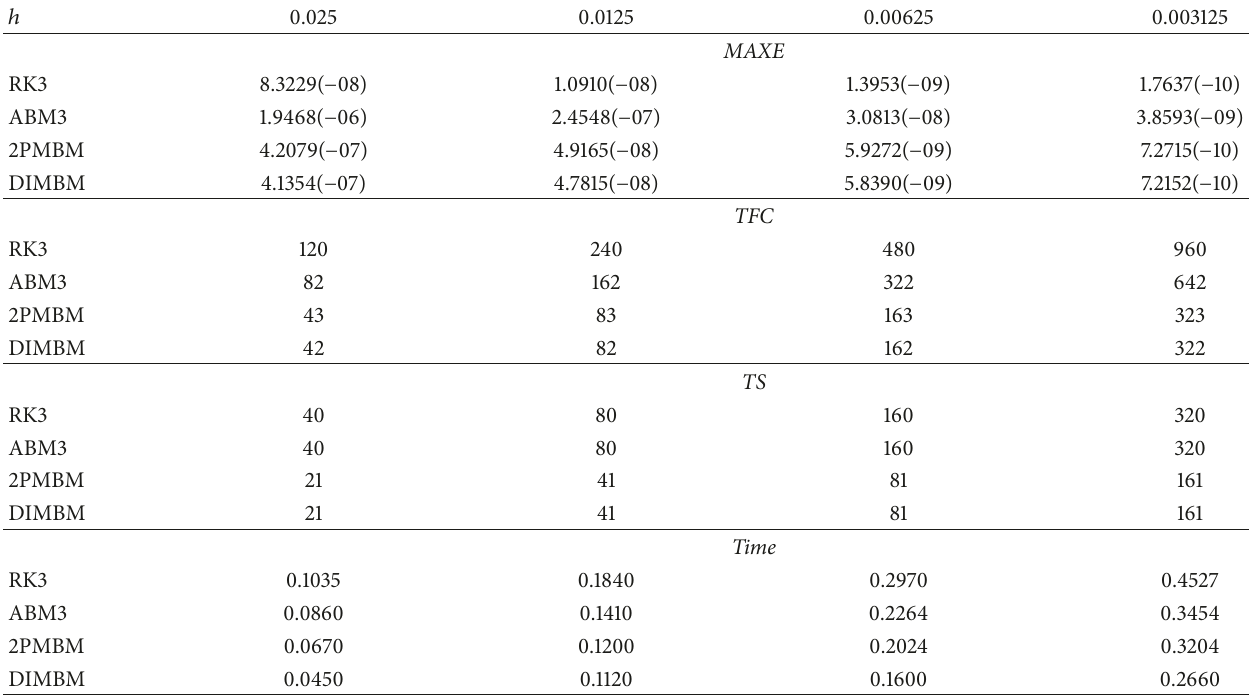
Table 1: Numerical results for Example